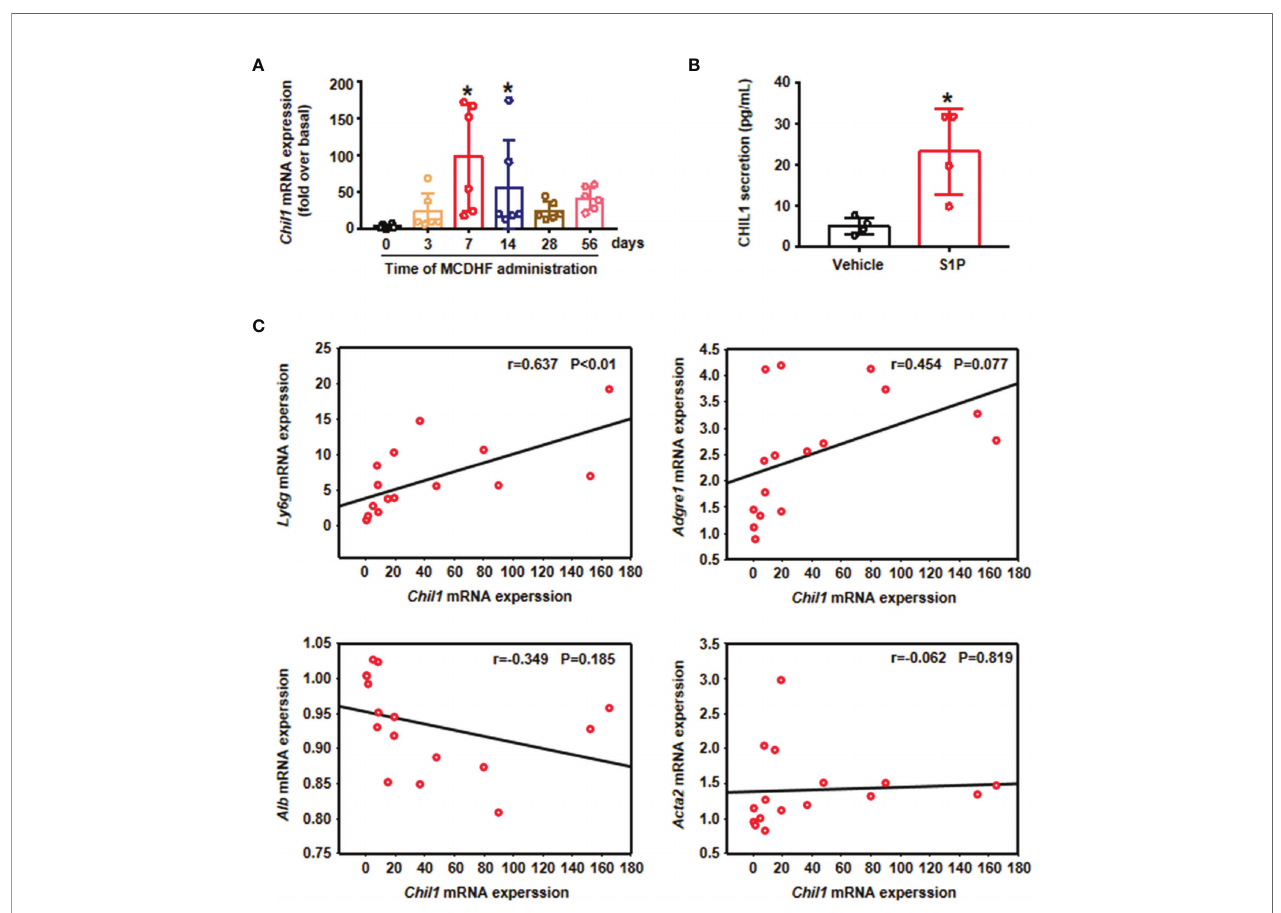
Nonparametric test (Kruskal-Wallis test) was used in (A) Student ’ s t test was used in (B) Pearson ’ s test was used in (C) *P < 0.05 vs. MCDHF treated group for 0 days or control. MCDHF, methionine-choline-de fi cient and high-fat diet; S1P, Sphingosine 1-phosphate; Chil1, Chitinase-like 1; Ly6G, lymphocyte antigen 6 complex, locus G; Adgre1, adhesion G protein-coupled receptor E1; Acta2, actin alpha 2; Alb,